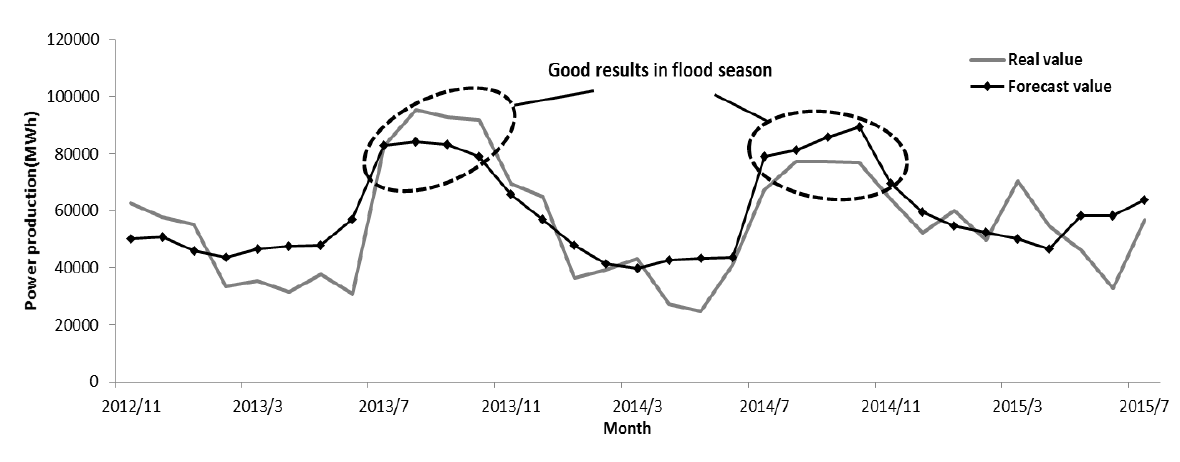
Figure 8. Prediction results of power production of SHP plants in Puer district.